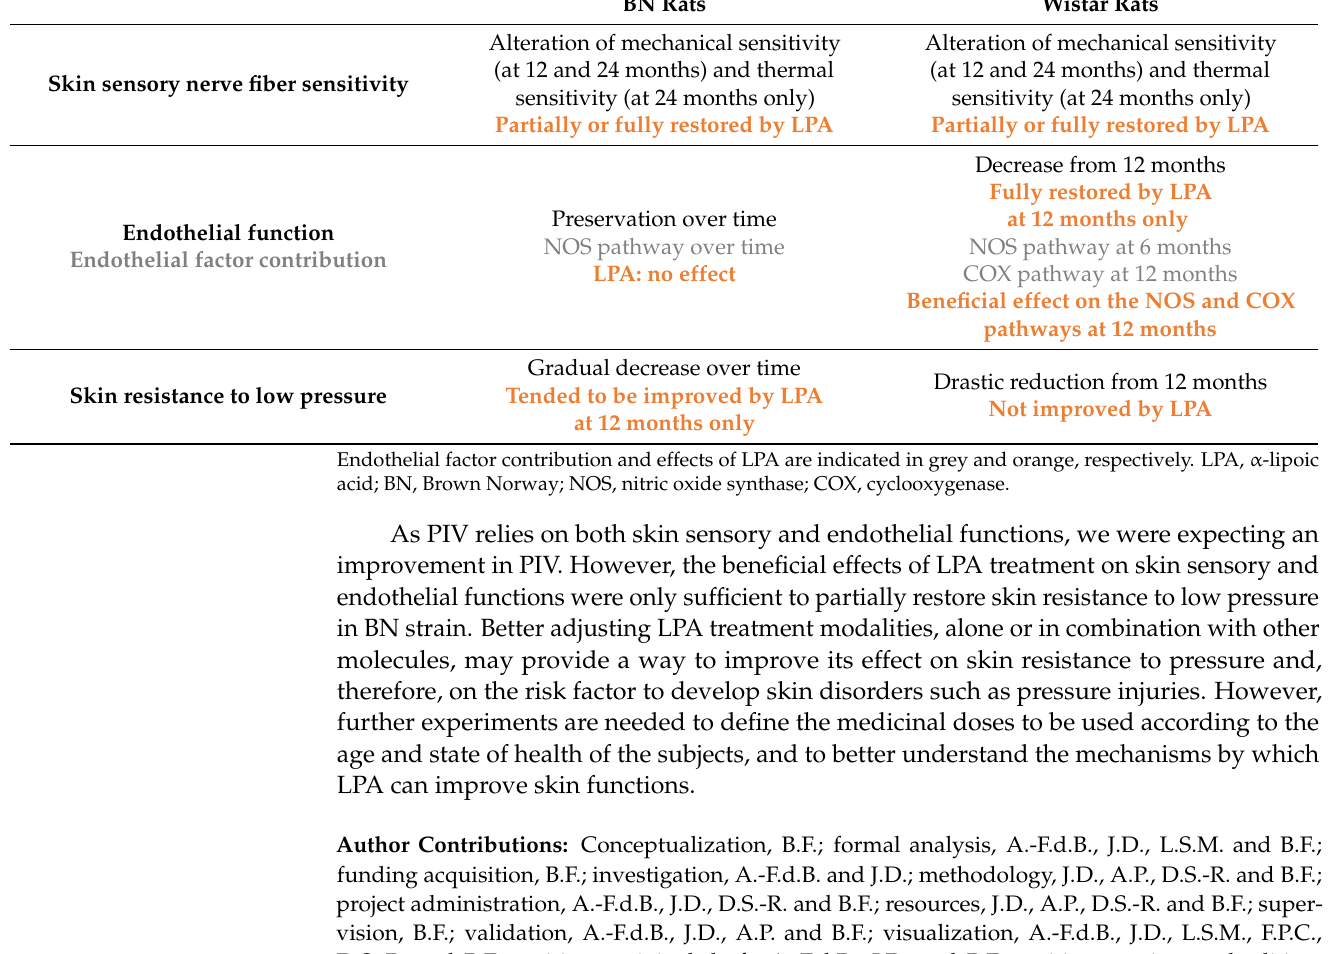
Table 1. Comparison of LPA effects on skin microcirculation and sensory nerve sensitivity in BN and Wistar rats. BN Rats Wistar Rats Alteration of mechanical sensitivity Alteration of mechanical sensitivity (at 12 and 24 months) and thermal (at 12 and 24 months) and thermal Skin sensory nerve fiber sensitivity sensitivity (at 24 months only) sensitivity (at 24 months only) Partially or fully restored by LPA Partially or fully restored by LPA